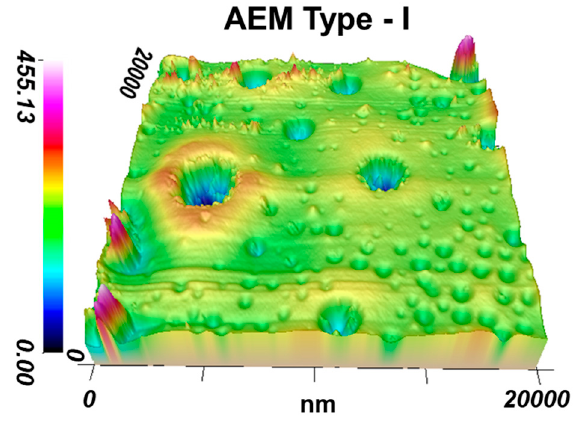
Figure 3. AFM image of air-dried sample of the AEM Type-I membrane.